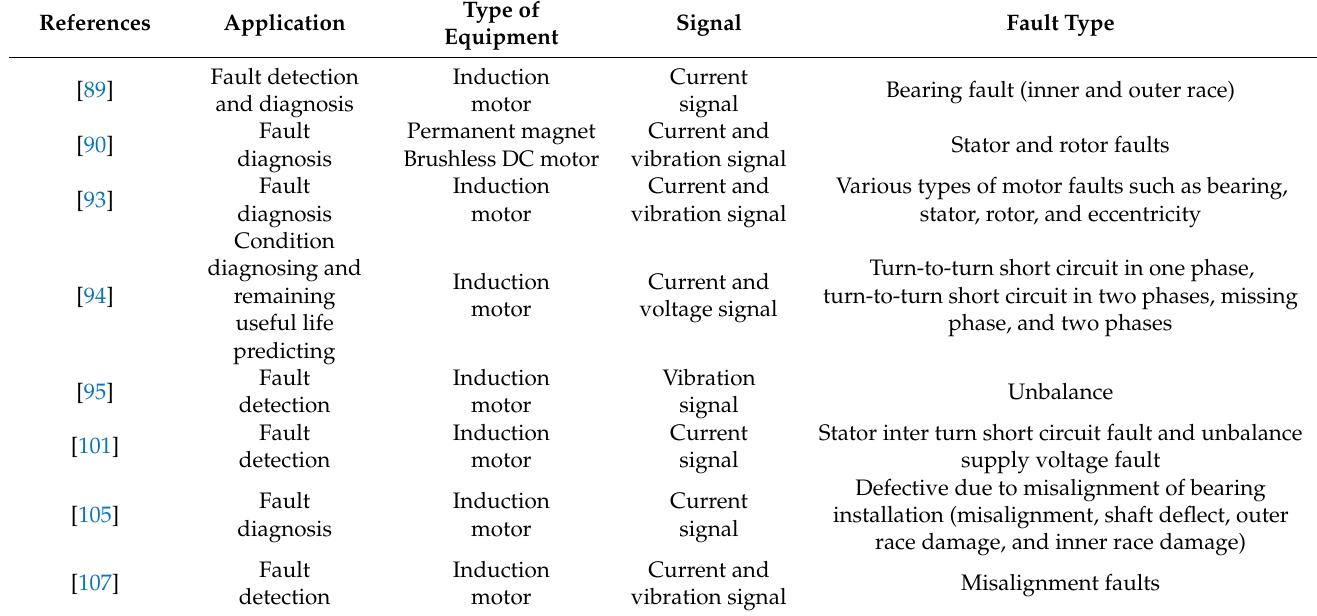
Table 10. Motor condition monitoring using artificial neural networks.